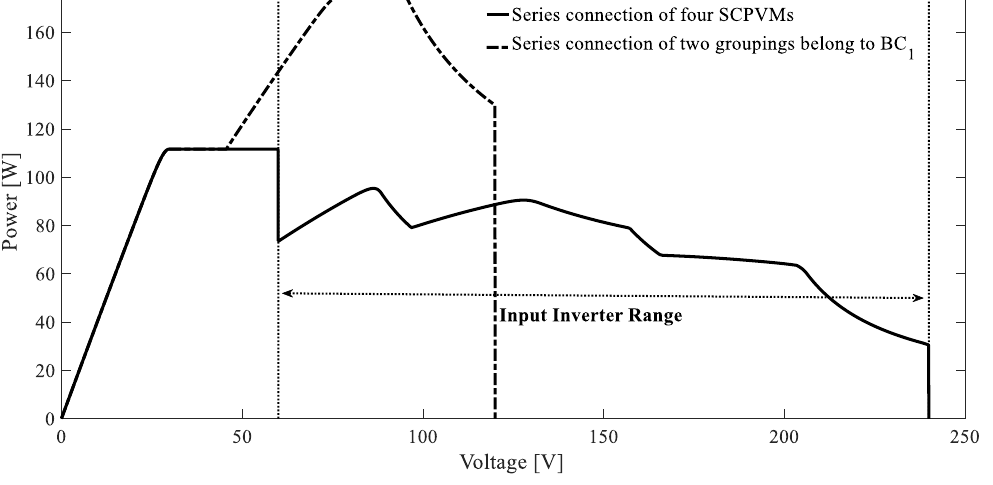
Figure 15. P-V characteristics (CASE I).